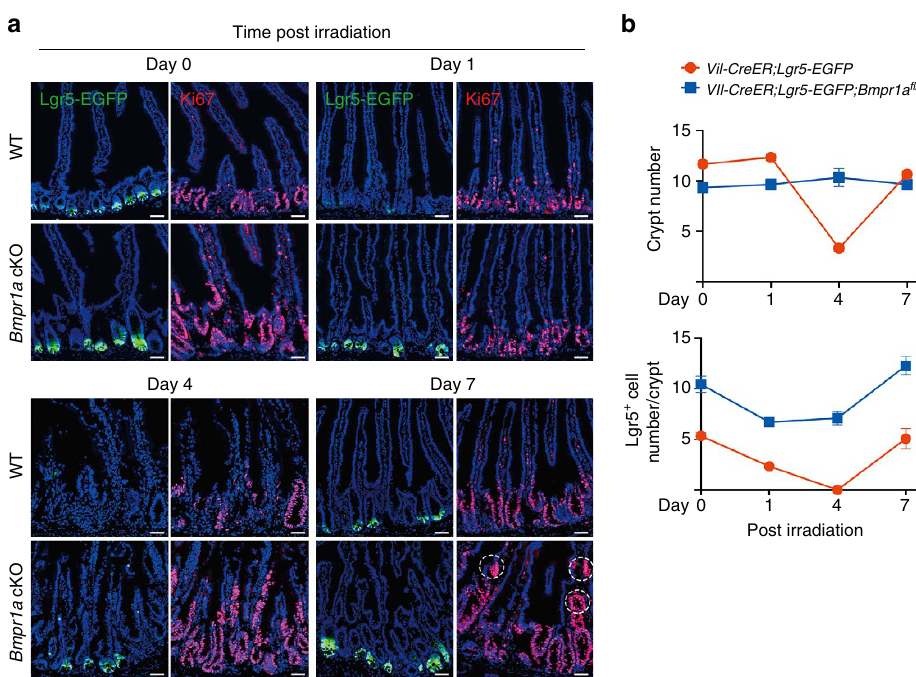
Figure 2 | Loss of BMP accelerates crypt regeneration and drives premalignant hyperproliferation after exposure to ionizing radiation. ( a ) Representative images of Lgr5-EGFP immunofluorescence and Ki67 staining in jejunum sections from Lgr5-EGFP and Vil-CreER;Lgr5-EGFP;Bmpr1a fl/fl mice at different time points after 10Gy abdominal X-ray radiation ( n ¼ 5 mice per genotype). The mice were irradiated 2 weeks following 5-day tamoxifen induction. Dotted lines delineate the proliferating epithelial invaginations on villus. ( b ) Quantification of crypt number and Lgr5 þ stem cell number in Lgr5-EGFP and Vil-CreER;Lgr5-EGFP;Bmpr1a fl/fl mice at different time points after 10Gy abdominal X-ray radiation. Data represent mean ± s.e.m. of n ¼ 5 mice per genotype. Scale bars, 50 m